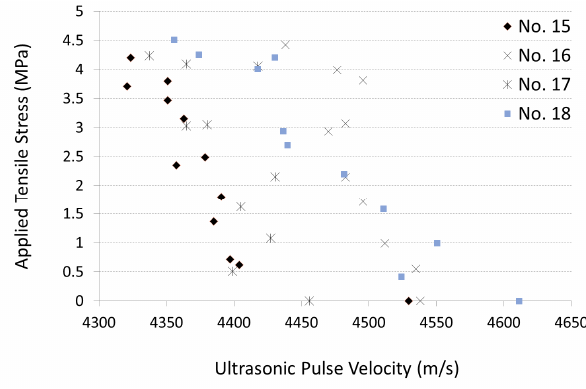
Figure 5. Ultrasonic Pulse Velocity (UPV) (m/s) vs. applied tensile stress (MPa) for Specimens No. 9 to No. 14.